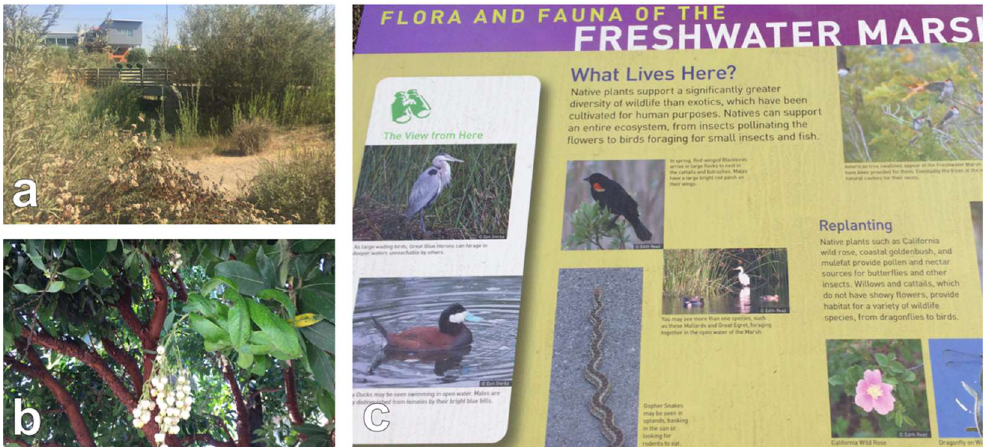
Figure 5. Examples of biodiversity that can support ecosystem services in Los Angeles natural stormwater treatment systems: ( a ) plant diversity at the South Los Angeles Wetland Park, ( b ) Bick- nell manzanita tree as a bee attractant, and ( c ) signage illustrating the biodiversity of the Ballona Freshwater Marsh.